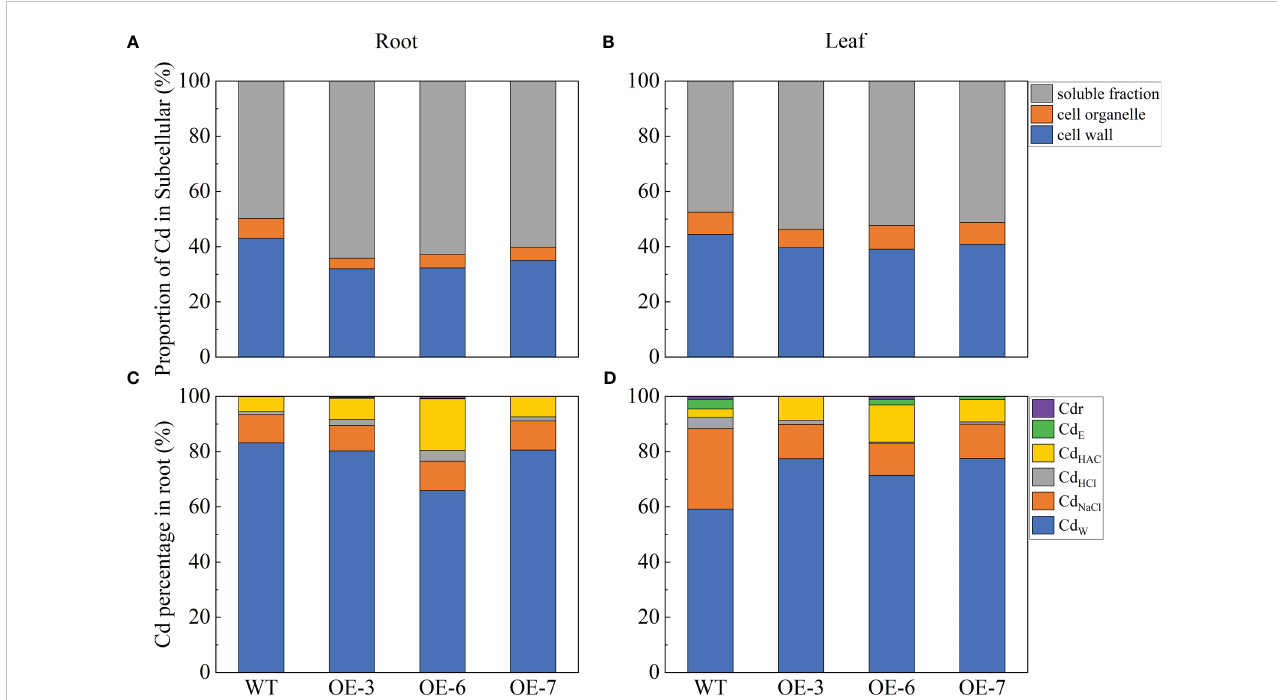
FIGURE 3 Cd subcellular distribution and Cd chemical forms in WT and SpCTP3 -overexpressing poplar roots and leaves treated with 100 m mol·L − 1 Cd for 30 days. (A) Cd subcellular distribution in the roots. (B) Cd subcellular distribution in the leaves. (C) Cd chemical forms in the roots. (D) Cd chemical forms in the leaves. Cd E , inorganic Cd; Cd W , water-soluble Cd; Cd NaCl , pectate- and protein-integrated Cd; Cd HAc , insoluble CdHPO 4 , Cd 3 (PO 4 ) 2 , and other Cd- phosphate complexes; Cd HCl , oxalic acid-bound Cd; Cdr, Cd in